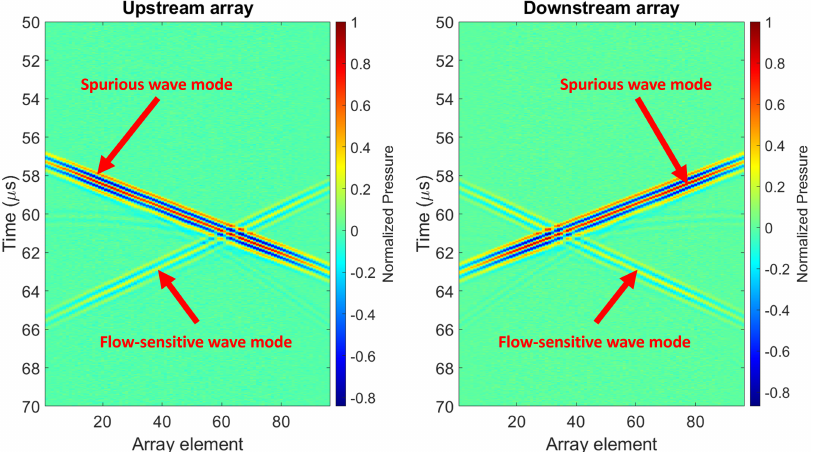
Figure 4. Synthetic pressure wavefield in water generated by simulated apertures of P4 − 1 probes in the context of array-based UFMs. SNR = 30dB per array element. The wavefields were generated using FIELD II